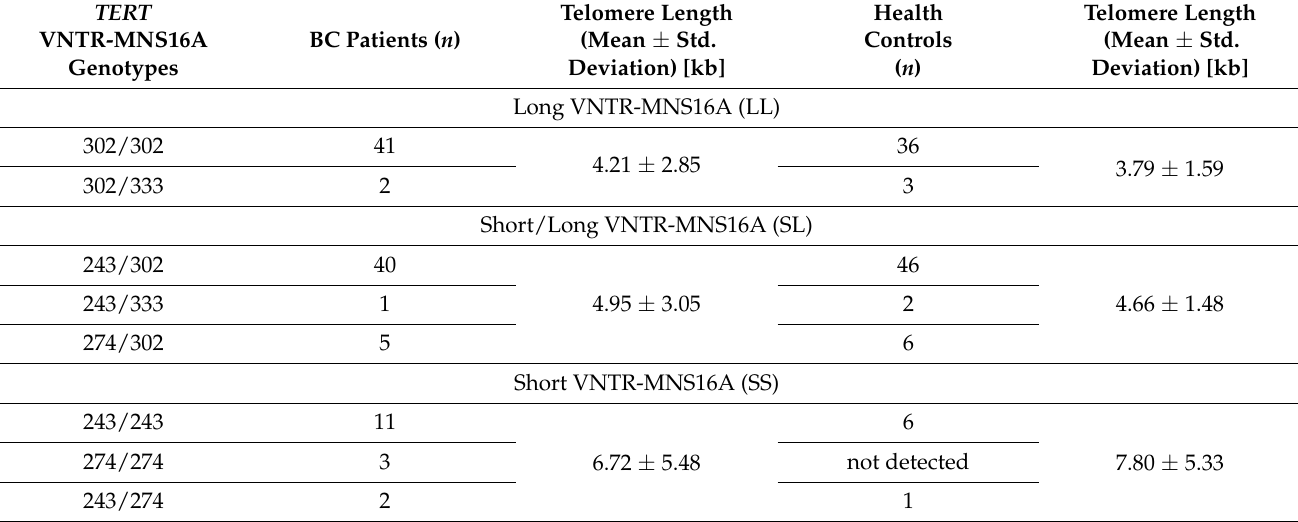
Table 2. TERT VNTR-MNS16A genotype distribution and telomere length in BC patients and healthy